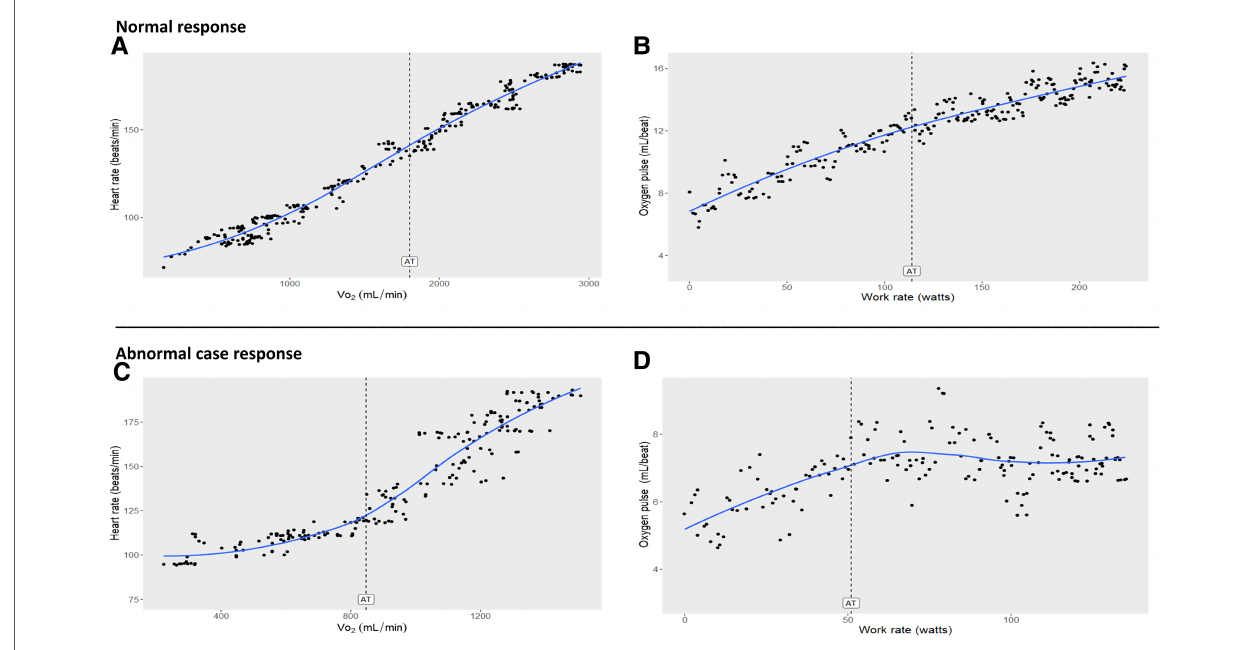
FIGURE 1 ( A,B) : Normal cardiopulmonary exercise test (CPET) responses (normal cardiac function) in a healthy 14-year old male control. Note there is little change in trajectories after AT compared to before AT. ( C,D ): Abnormal CPET responses (cardiac dysfunction) from the case participant 14-year old male with elevated hs-CRP and a family history risk factor for early-age coronary artery disease. Note the signi fi cant steepening of heart rate trajectory with abrupt fl attening of oxygen pulse after AT compared to before AT. AT, anaerobic threshold; Oxygen pulse, V ̇ O 2 /HR (index of stroke volume x arteriovenous oxygen difference); V ̇ O 2 , oxygen uptake. SI conversion factors: To convert V ̇ O 2 and AT values to L/min, multiply by.001; to convert V ̇ O 2 /HR (oxygen pulse, ml/beat) to L/beat, multiply by.001.